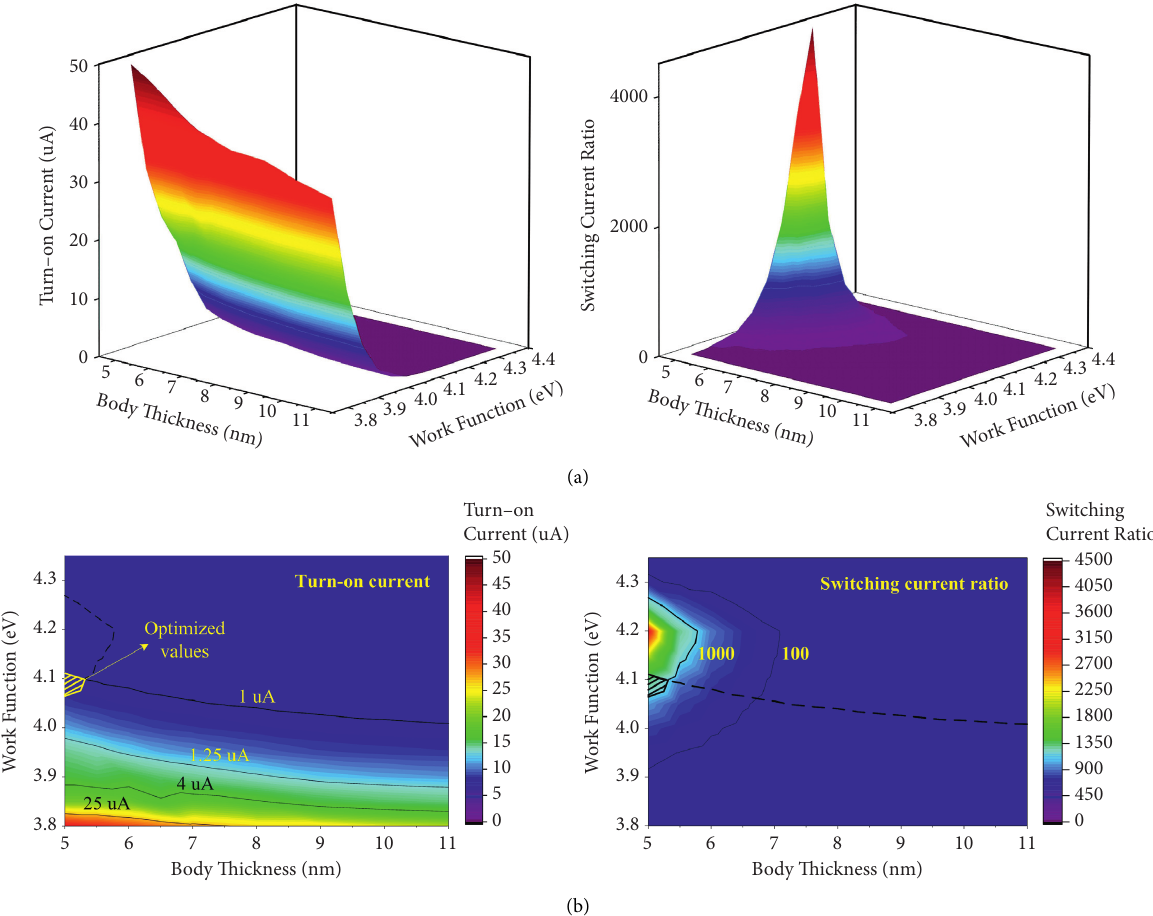
Figure 6: (a) Turn-on current I on and switching current ratio I on / I off with different body thickness and work functions and their (b) 2D contour